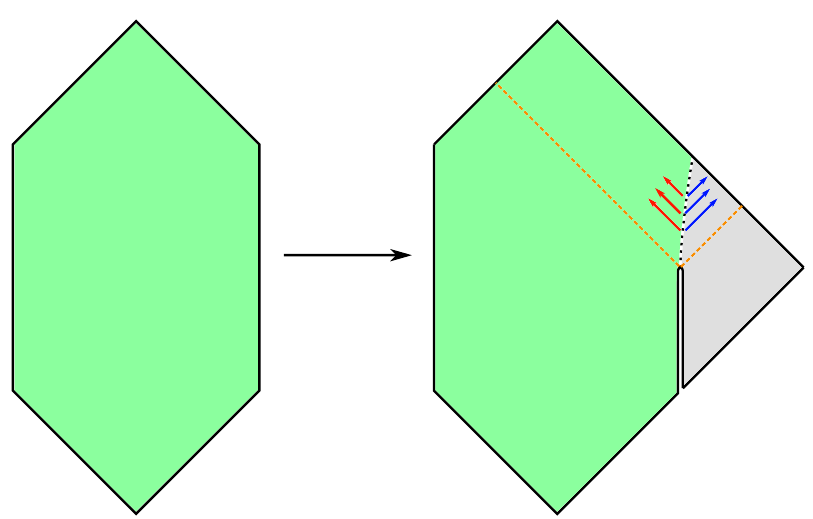
Figure 1 . The evaporating wormhole in JT gravity studied in [13]. Turning on the interaction between the green gravitational region and the grey reservoir region produces two positive energy shells, shown as orange dashed lines. After this, positive energy Hawking radiation (shown in blue) leaks out into the reservoir system, while negative energy radiation (shown in red) falls into the right black hole and gradually decreases its